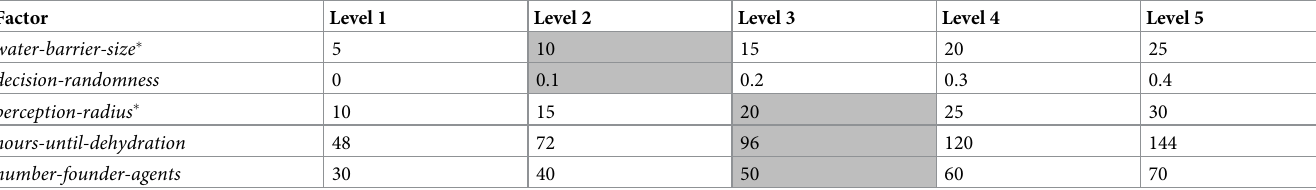
Table 3. Factor levels of sensitivity experiments.